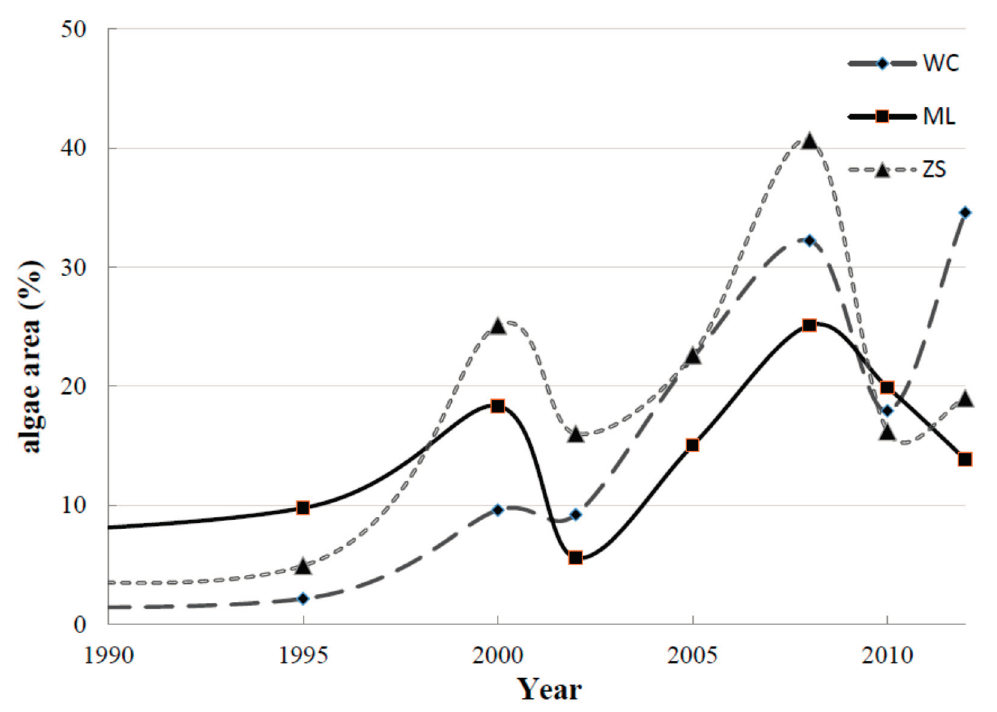
Figure 4. Change tendency of algae area within the three lake divisions since 1990–2012.